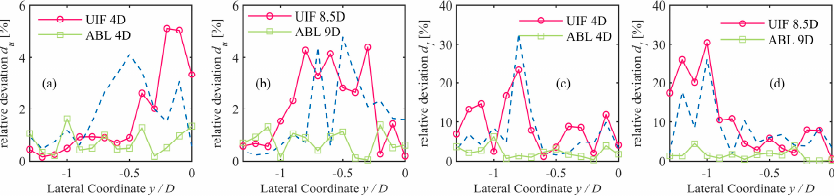
Figure 19. Relative deviation of the mean wake velocity and the turbulence intensity. The dashed line denotes the experimental error in the UIF condition.